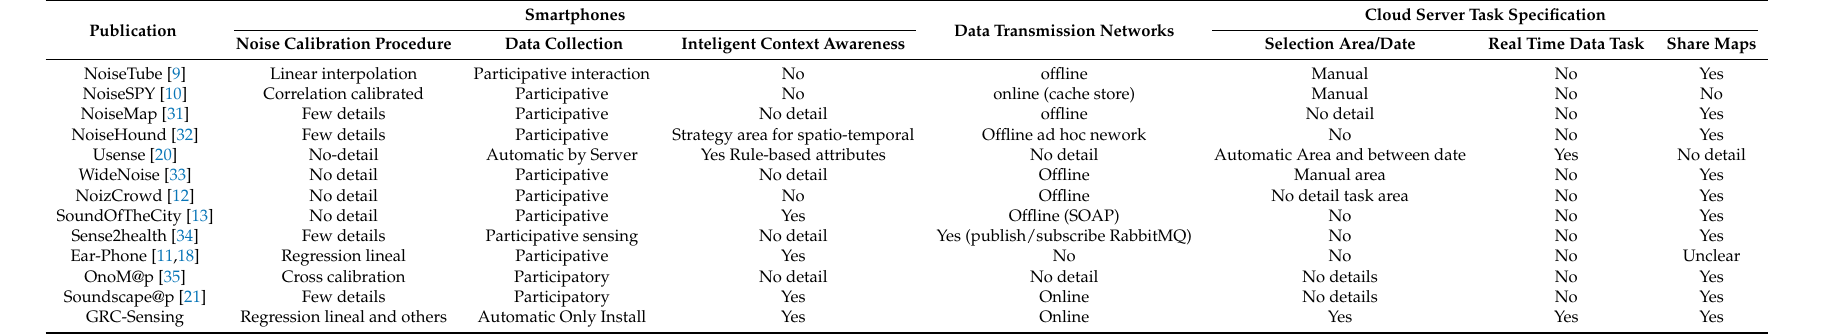
Table 1. Characteristics of crowdsensing-based noise assessment